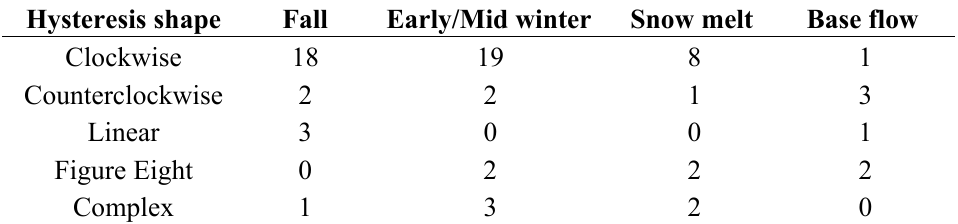
Table 7. Number of turbidity event hysteresis loop patterns by season at all study catchments. Hysteresis shape Fall Early/Mid winter Snow melt Base